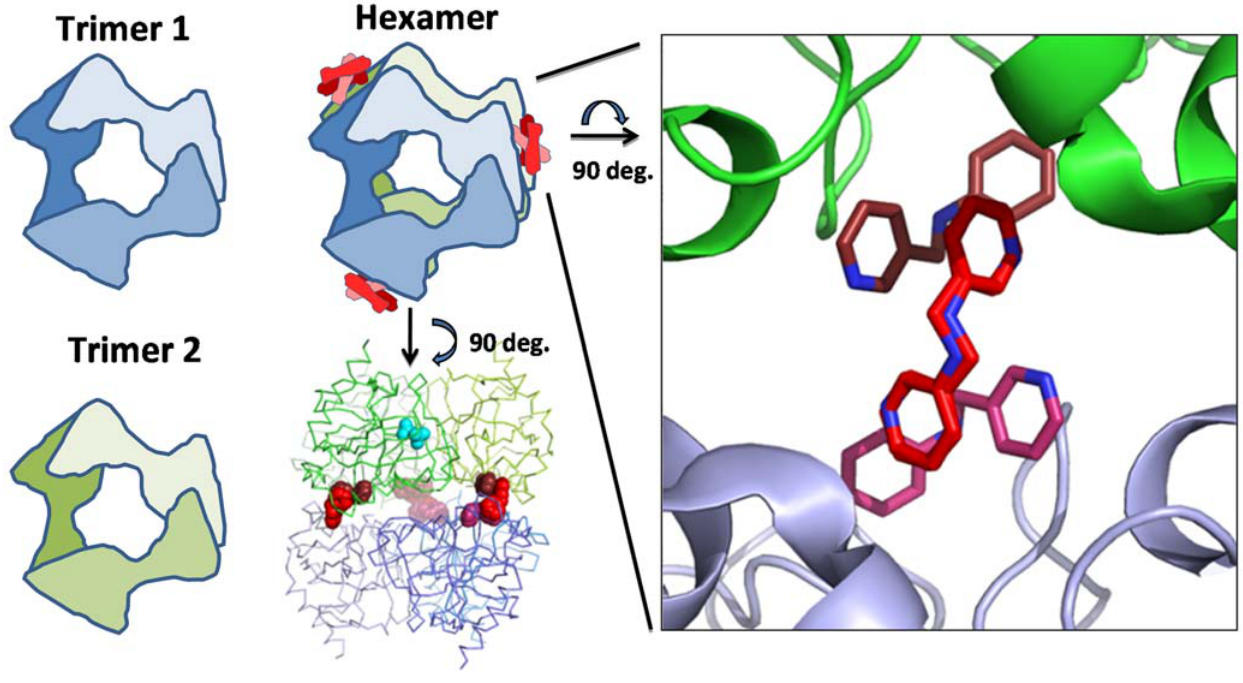
Figure 2. B.pseudomallei inorganic pyrophosphatase with bound ligand at an oligomeric interface. Homo-hexameric bacterial inorganic pyrophosphatase is a dimer of trimers (blue and green). The illustration shows the hexamer structure in a complex with three ligand fragment molecules (red spheres and stick structures represent fragment FOL 110), each of which is located at one of three ‘‘dimer of trimer’’ interfaces (1.5 ligands per monomer) (PDBID:3EJ0). The location of one pyrophosphate substrate (cyan spheres) at the active site of one of the monomers is indicated here based on the superimposed structure of the hexamer with pyrophosphate bound in the active site (PDBID:3EIY). The binding sites of the ligands (red) are clearly seen in a pocket formed by the homo-oligomeric assemblage, which is distant from the active site where pyrophosphate (cyan) binds.